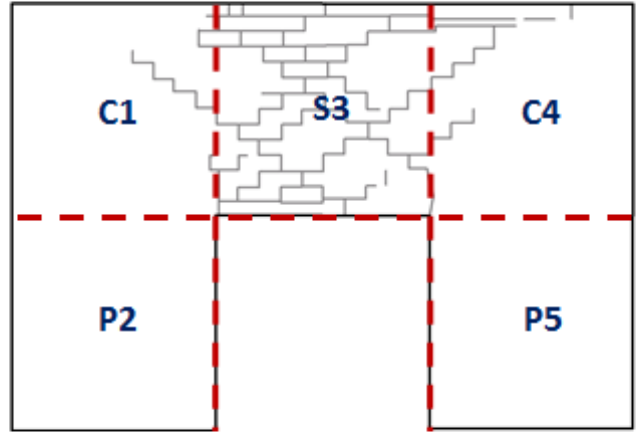
Figure 15. The discretization of the damaged wall specimen by Allen et al. [51].